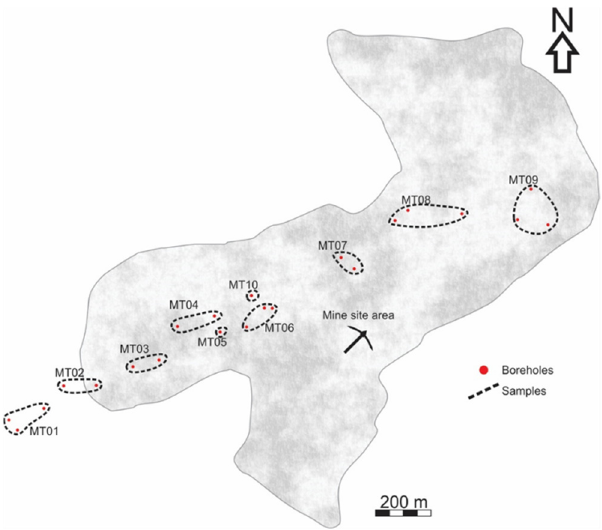
Figure 1. Schematic mine site map showing the relative geographic location of the boreholes and samples.